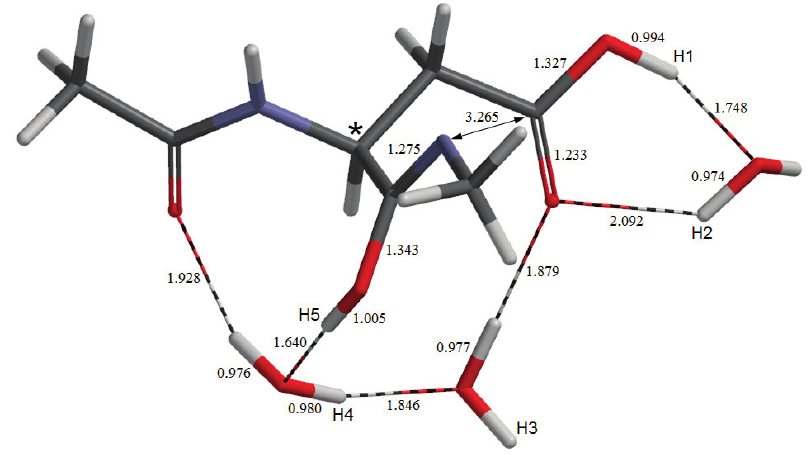
Figure 8. The geometry of the fourth intermediate IM3 . Selected bond distances are shown in Å.